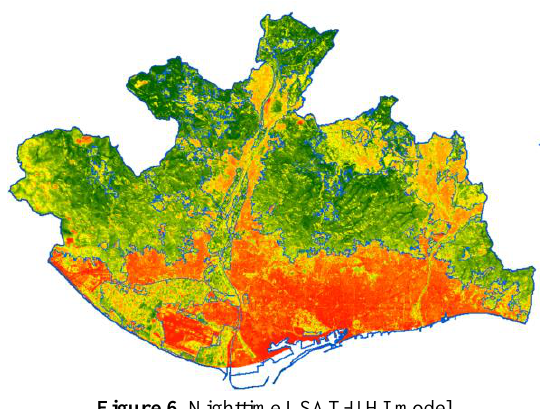
Figure 6 . Nighttime LSAT-UHI